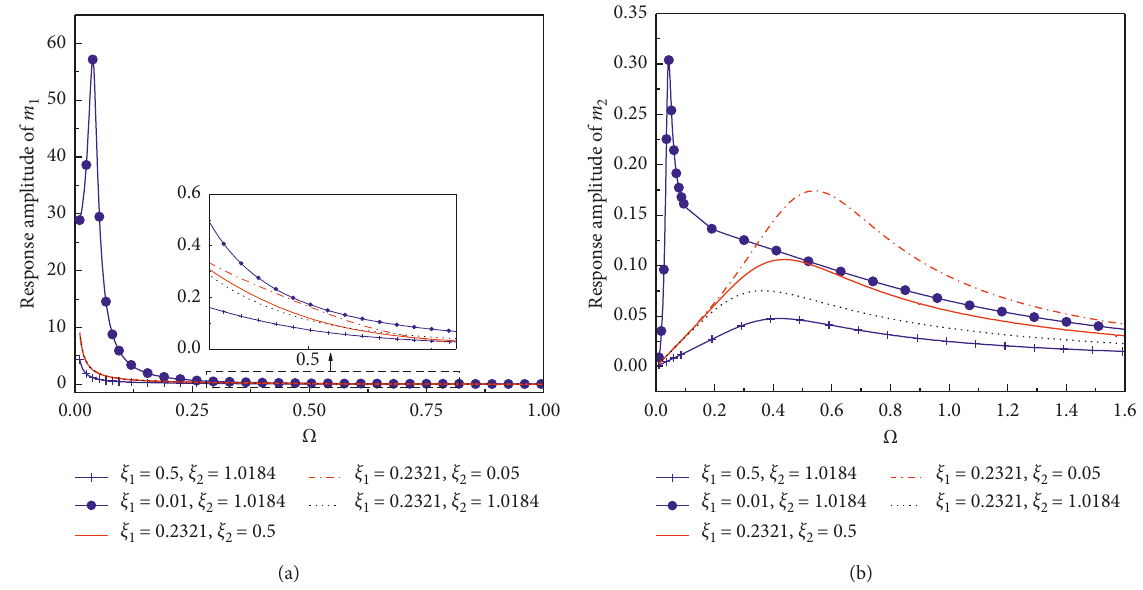
Figure 8: Nondimensional natural frequency for different values of initial displacement x order natural